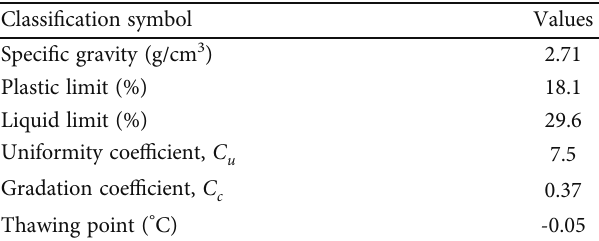
Table 2: Physical parameters of the